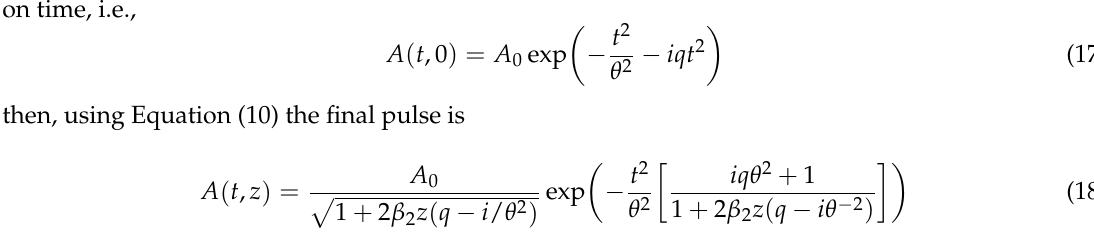
  2 , ztA Figure 4. Same as Figure 2, but for the intensity ( | A ( t , z ) | 2 ) of the pulse presented by Equation (16). Figure 4. Same as Figure 2, but for the intensity ( ) of the pulse presented by Equation (16). (In this example, ω 0 = − 4/ θ ). (In this example,  /4 ). 0